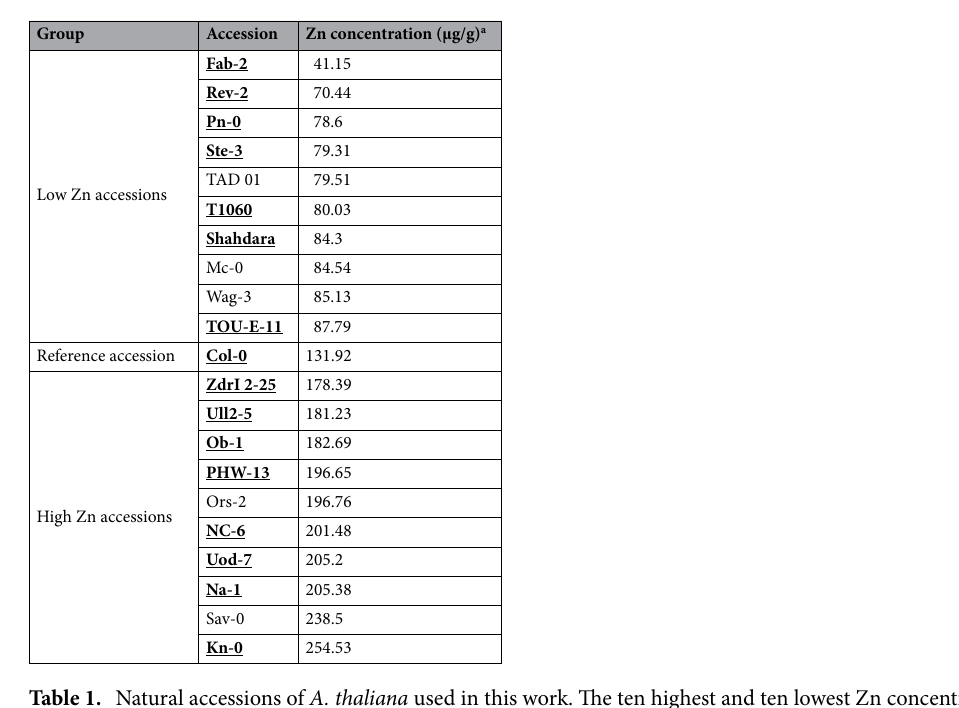
Table 1. Natural accessions of A. thaliana used in this work. The ten highest and ten lowest Zn concentration in leaves are shown, from the 349 accessions found at the Ionomics Atlas. Accessions used are in bold and underlined. a Data generated by ICP-MS and downloaded from the ionomics Atlas (http://www.ionom icshu b.org/ionom icsat